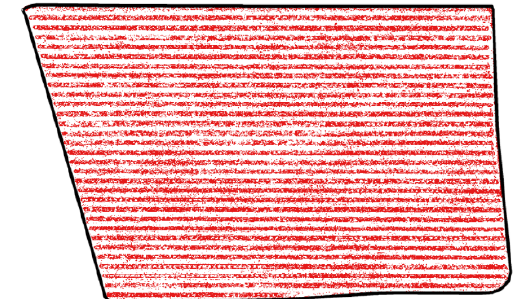
Figure 5. Treed regions detected on the entropy NDVI image for orchard#1.